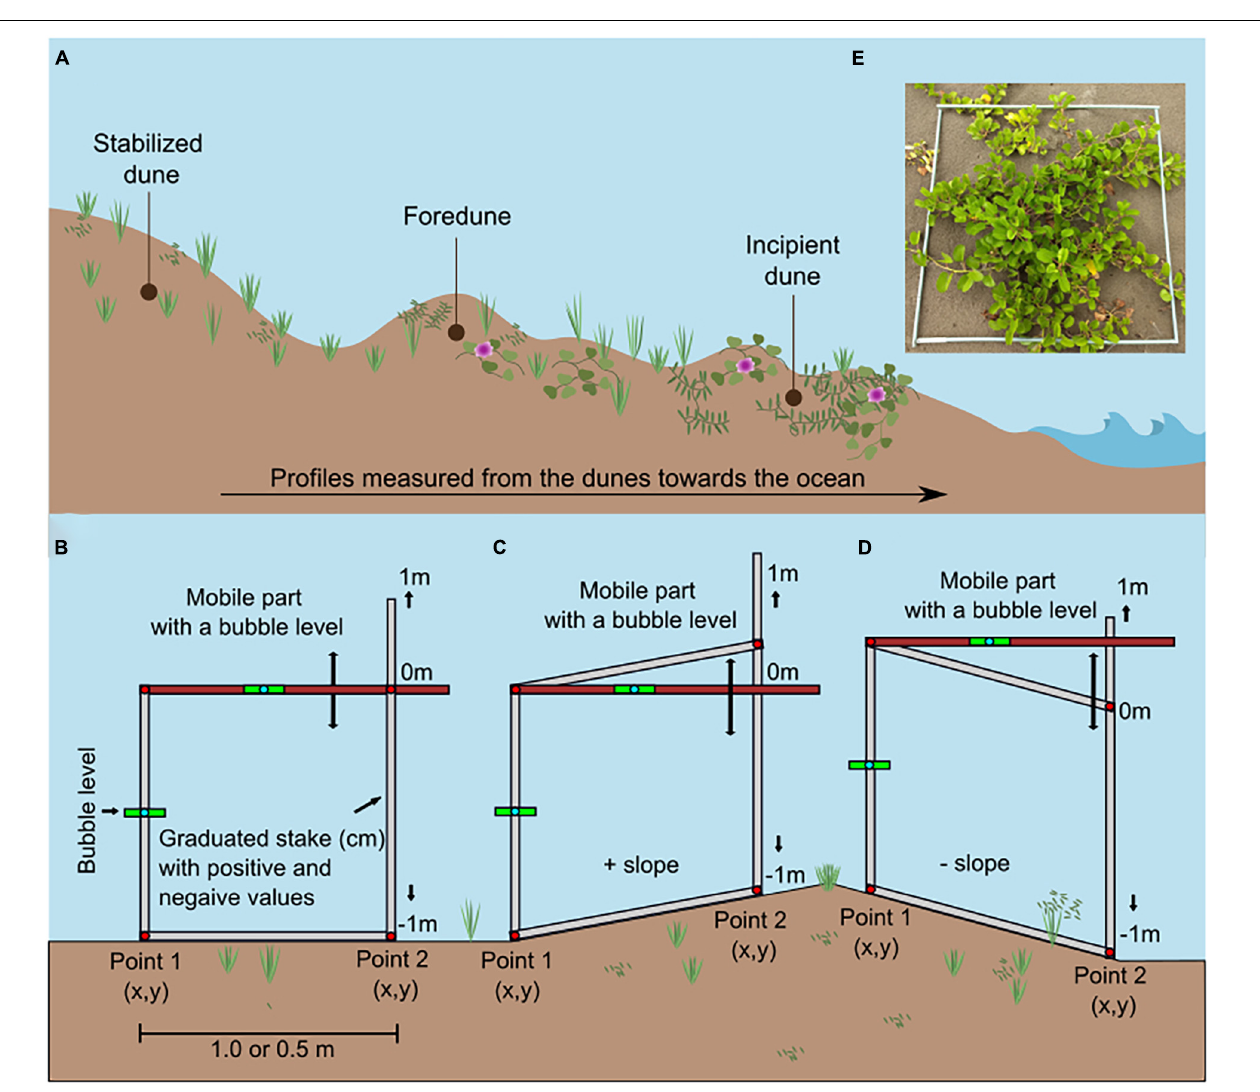
FIGURE 3 | (A) Beach and dune profile showing the direction in which the profiles were measured from the foredune to the swash zone. (B) A self-made instrument to measure changes in height (y) between two points separated by a known distance (x). Each time that the user advances, in one-m segments (or 0.5 m segments), changes in height can be measured. Because of the direction in which the profiles were measured (from the dunes to the beach), positive slopes were mainly associated with protected faces of the dune (C) , and negative slopes with the exposed face (D) . (E) Picture showing one of the plots where vegetation was